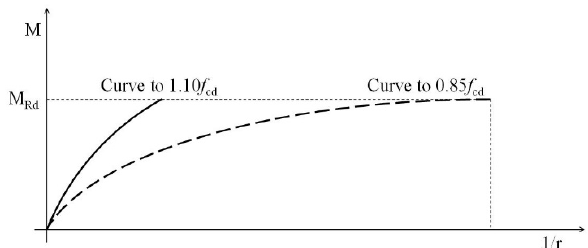
Figure 2. Moment-curvature diagram according to the Brazilian Standard NBR 6118 [1].